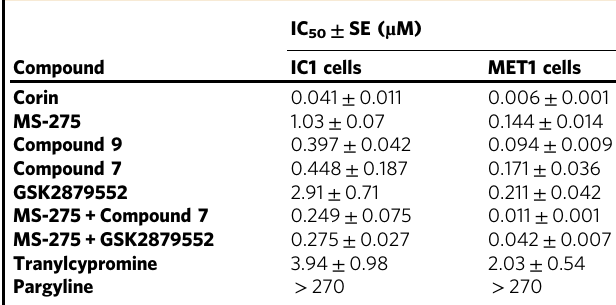
Table 3 Anti-proliferative effects of corin and